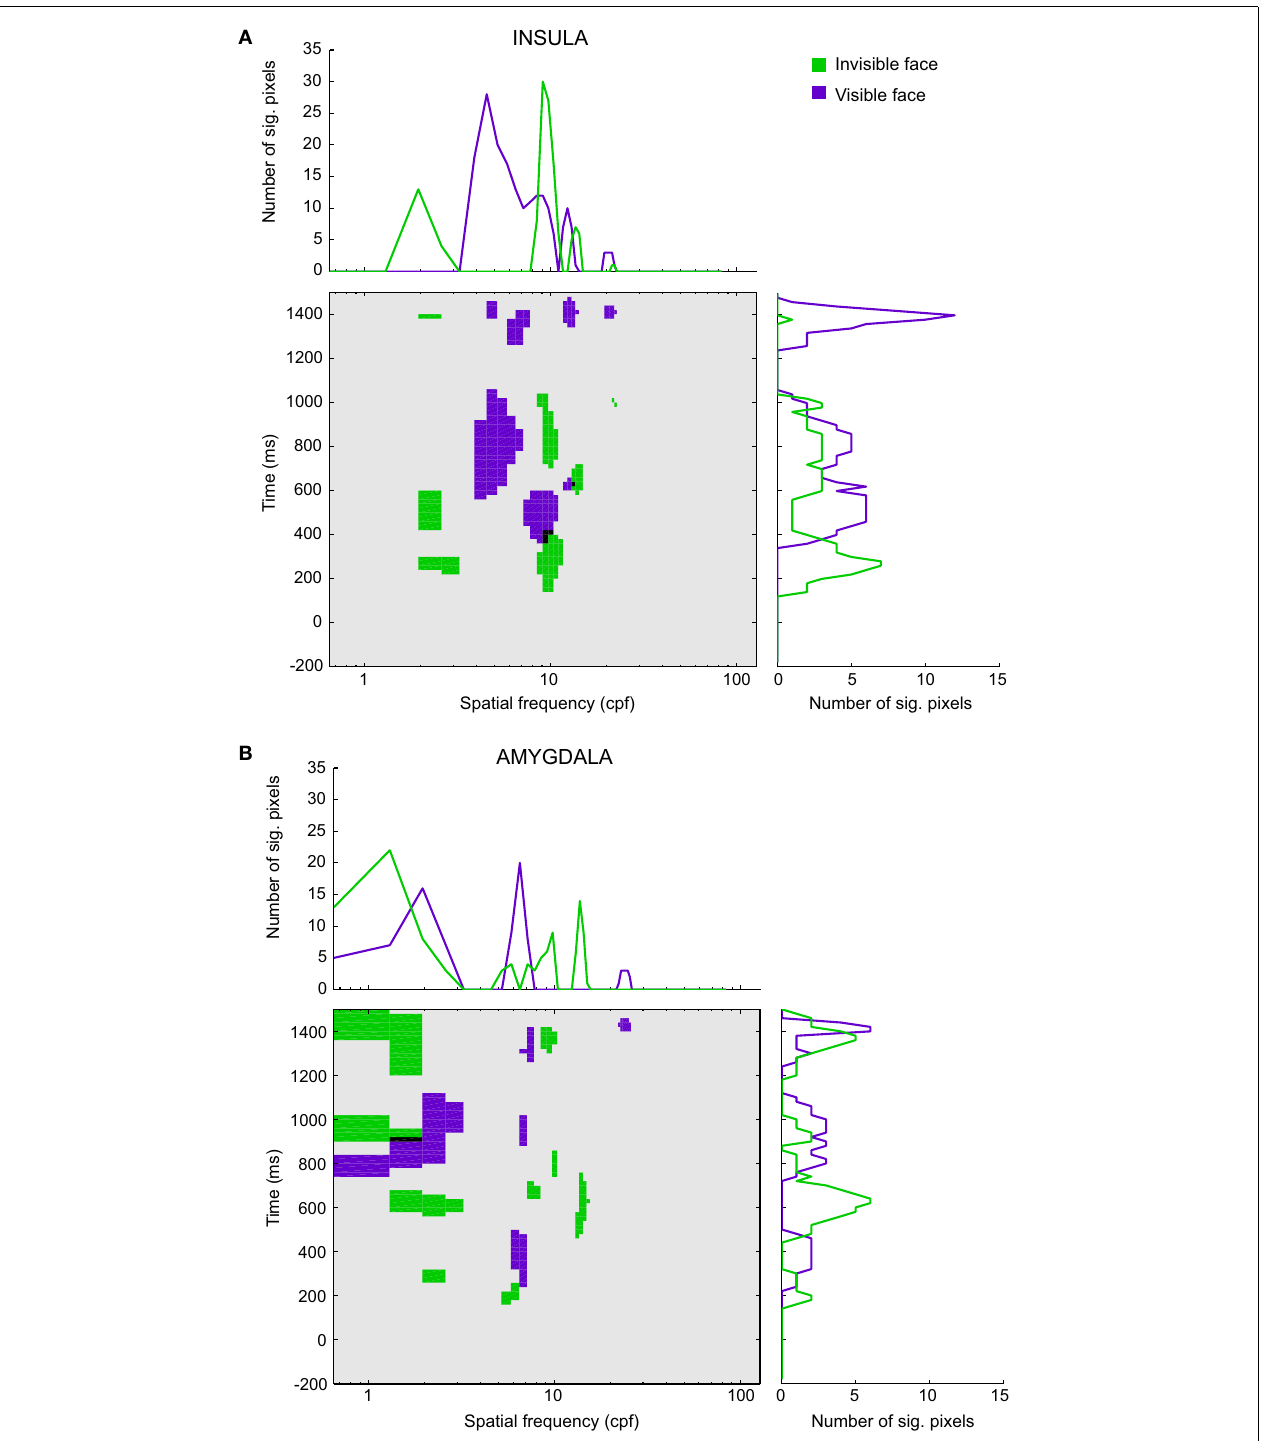
stimulus onset and 1500ms after stimulus onset. Black regions indicate the overlap between the awareness conditions.The line graphs (summation plots) show the number of significant pixels across time for each spatial frequency (top) or across spatial frequencies for each time segment